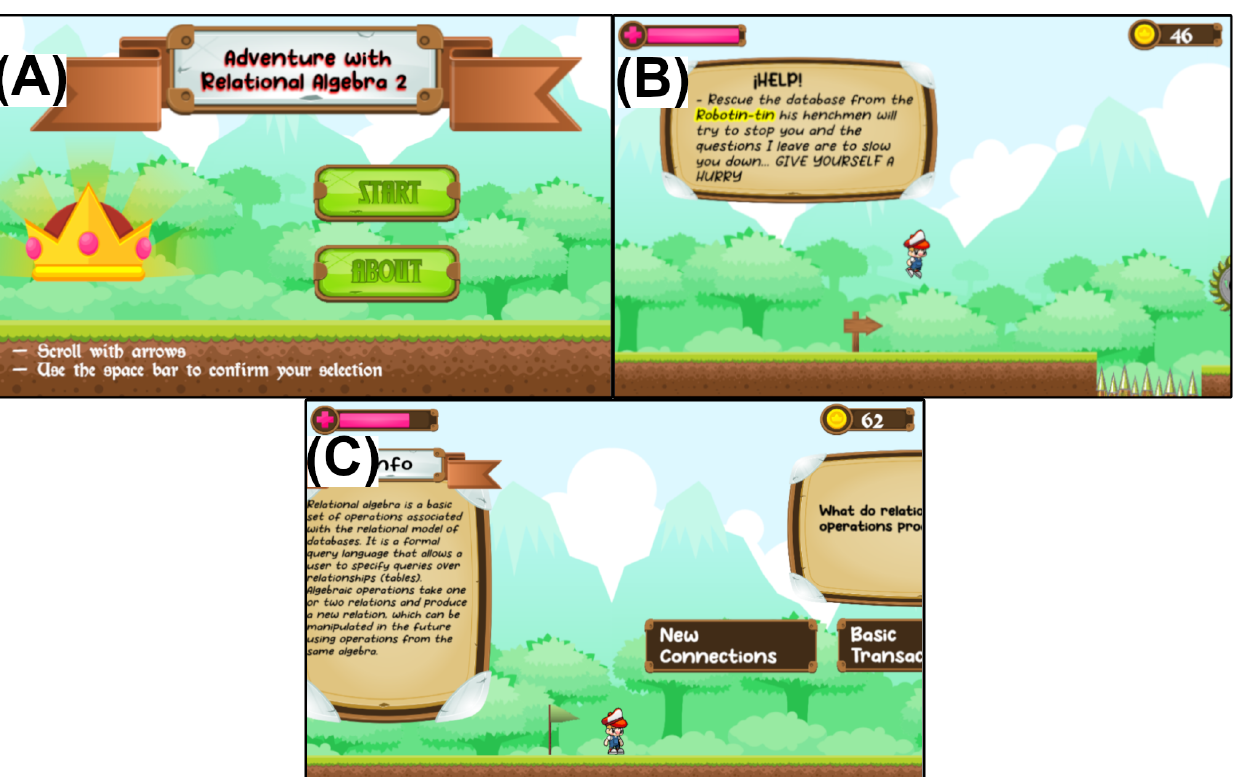
Figure 5. Some of the graphical interfaces of the SG are ( A ) the main menu; ( B ) the objective of the video game is presented; and ( C ) educational information and a question for the end user are presented.